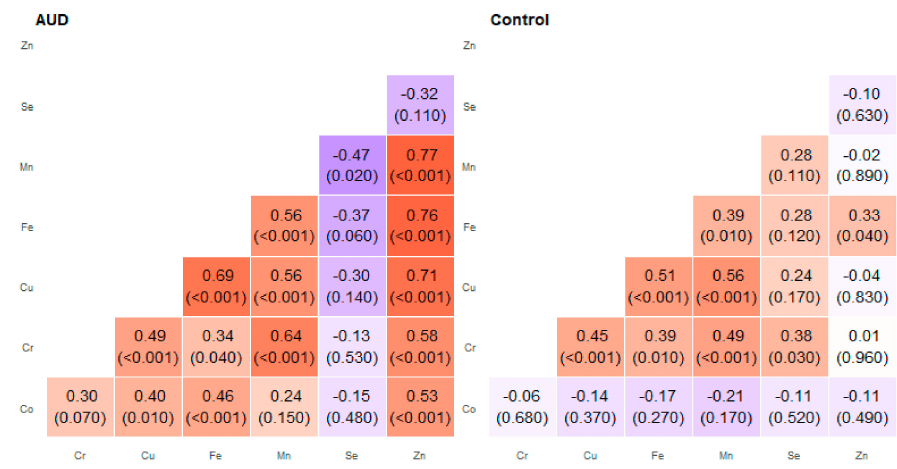
Figure 5. Correlation matrix of Spearman coe ffi cient charts in the foot of the hippocampus region in the alcohol use disorder and control groups.